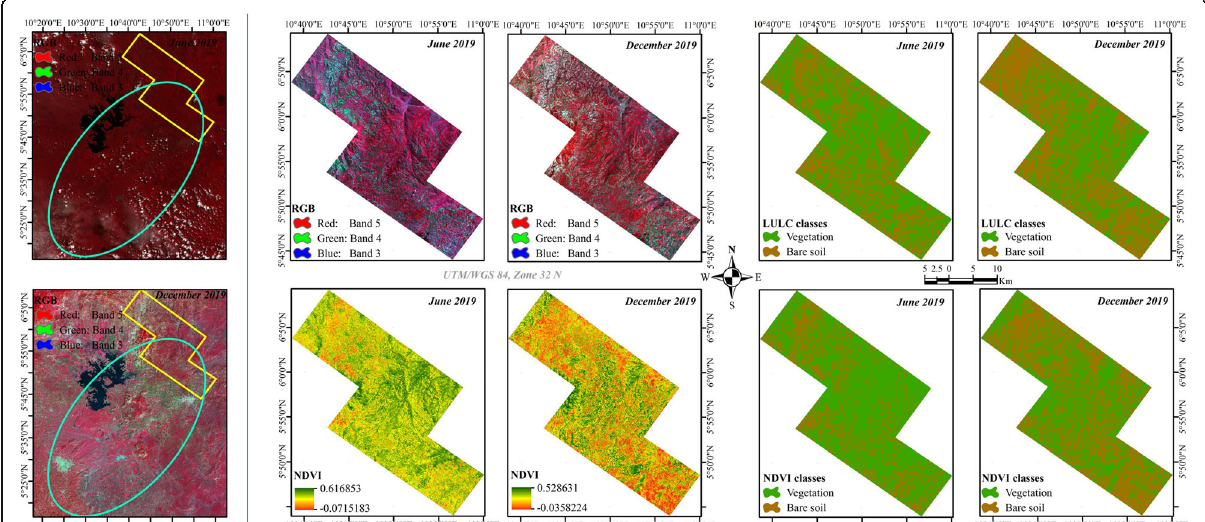
Fig. 14 Subsets of land cover extent